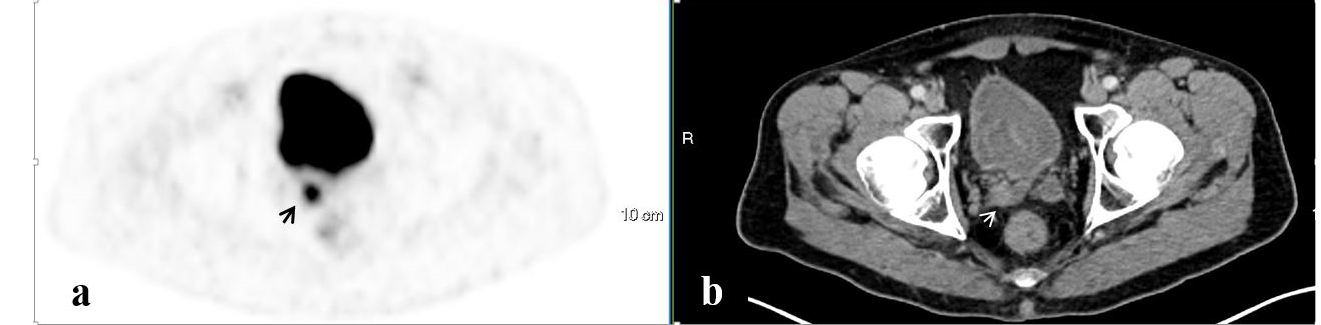
Figure 1. A PSMA-avid lesion in a solitary pelvic lymph node. 68Ga-PSMA scan, maximum intensity projection (MIP) ( a ) corresponding PET ( b ) and CT ( c ) axial slices demonstrating focally increased uptake in the solitary pelvic lymph node on the left (arrows).